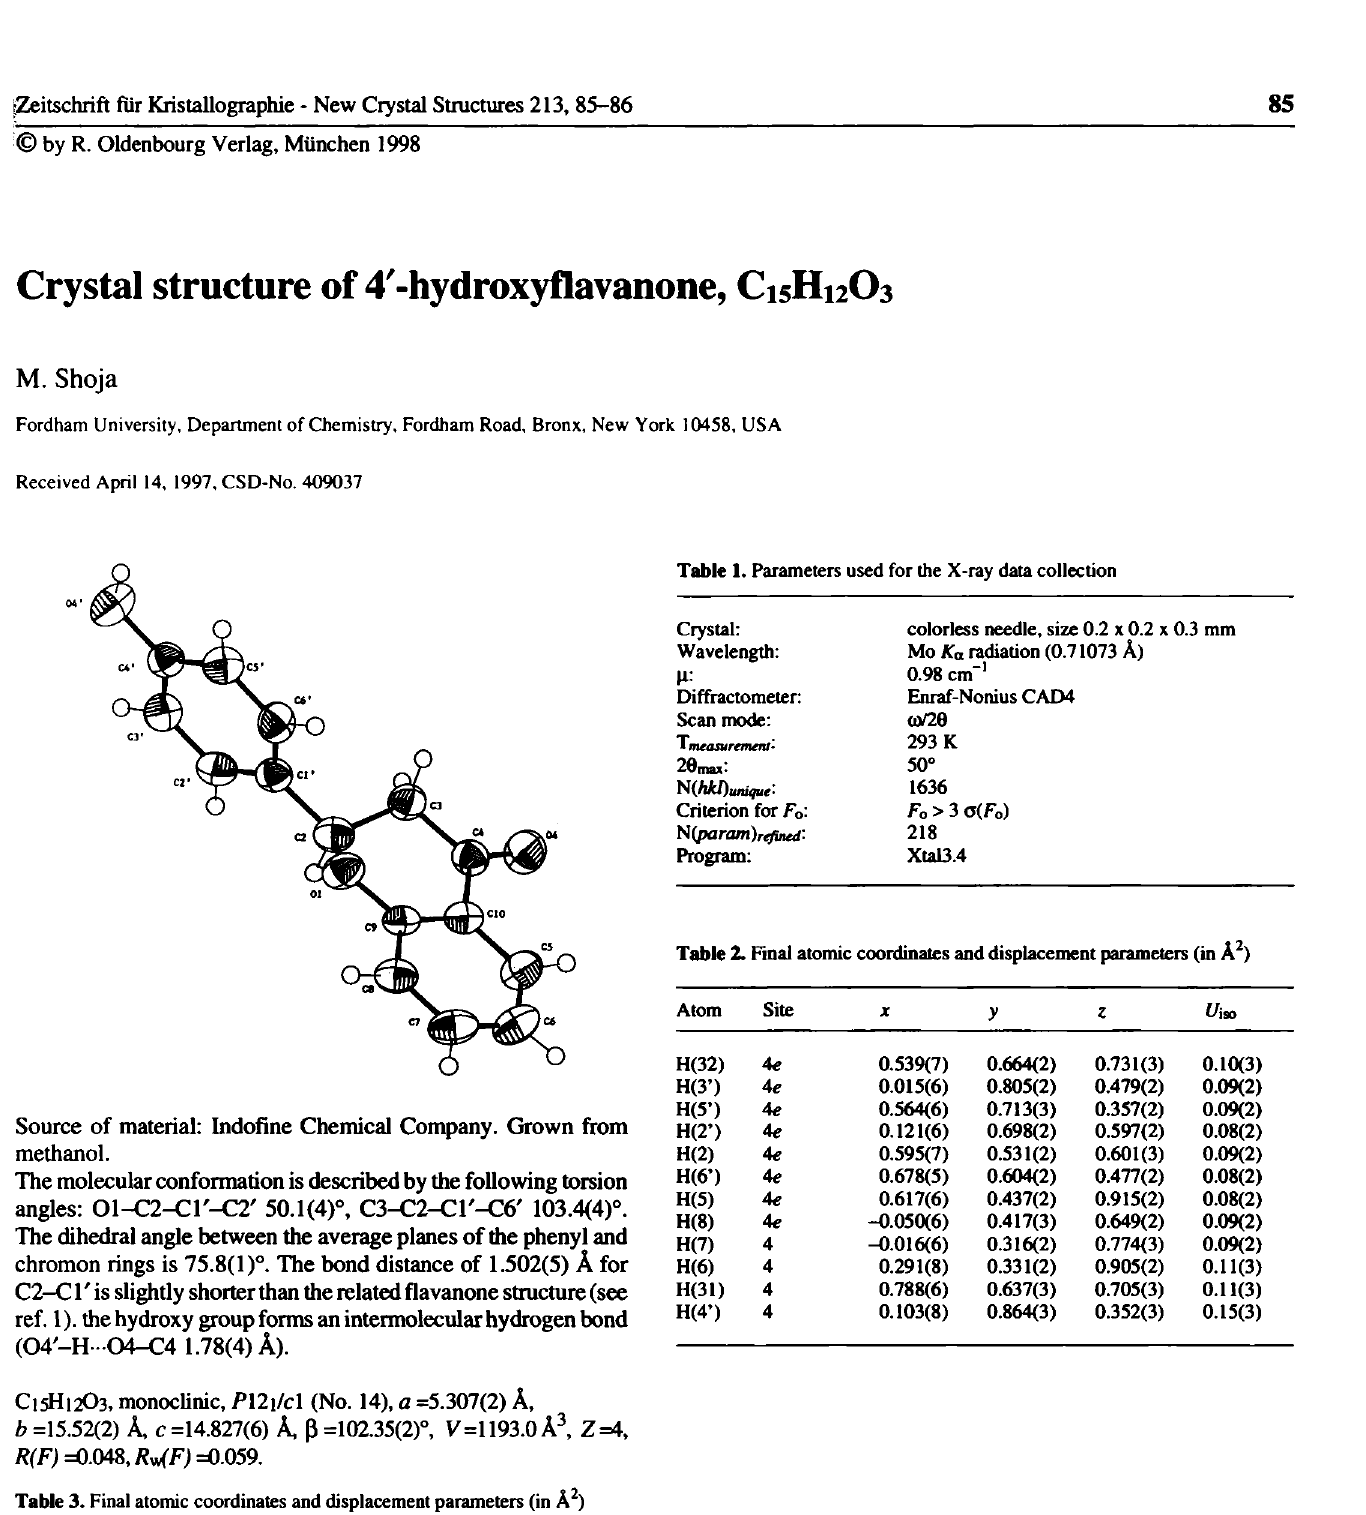
Table 3. Final atomic coordinates and displacement parameters (in Â^)